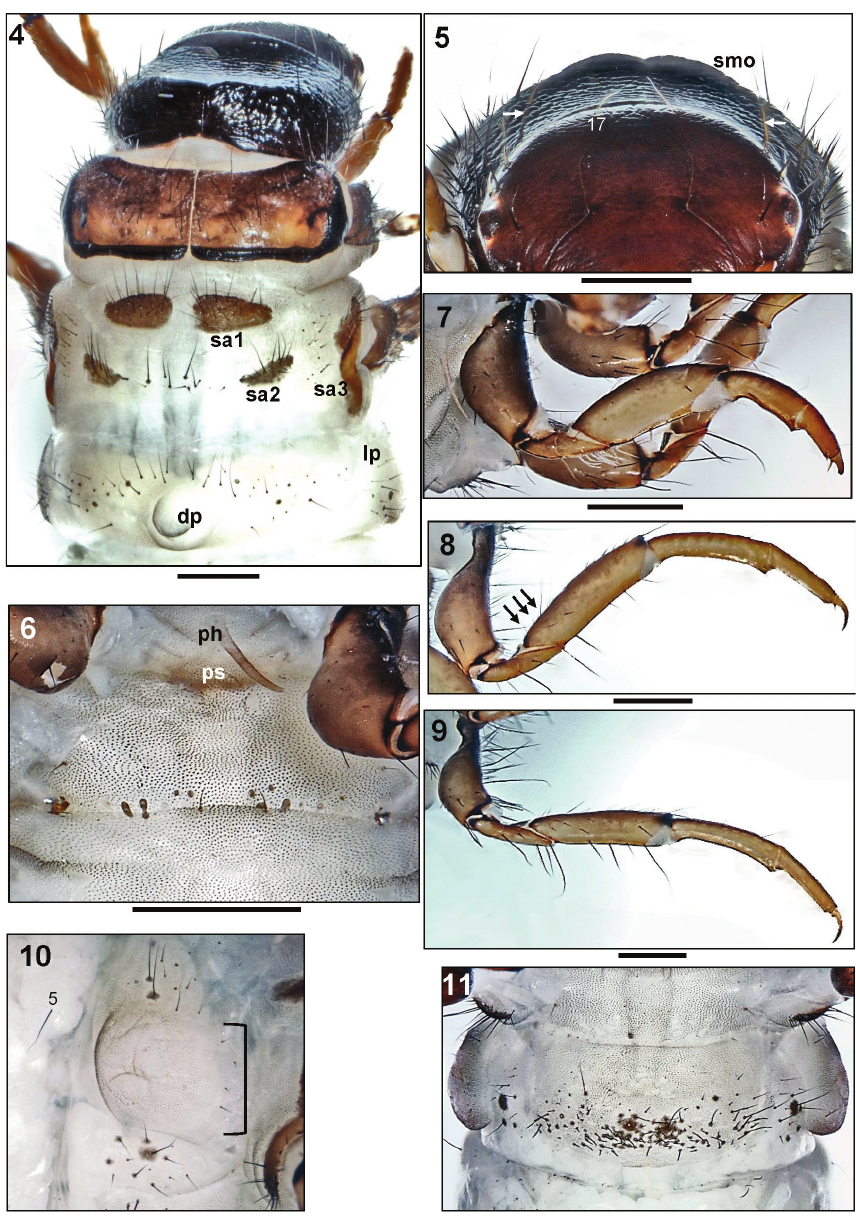
Figures 4–11. Drusus dudor Oláh, 2017, 5 th instar larva. 4 Head, thorax and abdominal segment I, dorsal view (dp: dorsal protuberance; lp: lateral protuberance; sa1, sa2, sa3: metanotal setal areas 1, 2 and 3) 5 Head and pronotum, frontal view (arrows: long dark setae not reaching dorsal midline; smo: smooth outline of pronotal ridge; numbers refer to setal positions) 6 Prosternum, ventral view (ph: prosternal horn; ps: prosternite) 7 Left fore leg, anterior view 8 Left mid leg, anterior view (arrows: proximodorsal setae) 9 Left hind leg, anterior view 10 Lateral protuberance, right lateral view (bracket: anterolateral setae; number 5 refers to setal position) 11 Abdominal sternum I, ventral view. Scale bars: 0.5